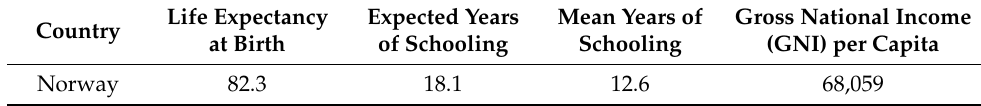
Table 2. Information for calculating HDI index for Norway. Life Expectancy Expected Years Mean Years of Gross National Income Country at Birth of Schooling Schooling (GNI) per Capita Norway 82.3 18.1 12.6